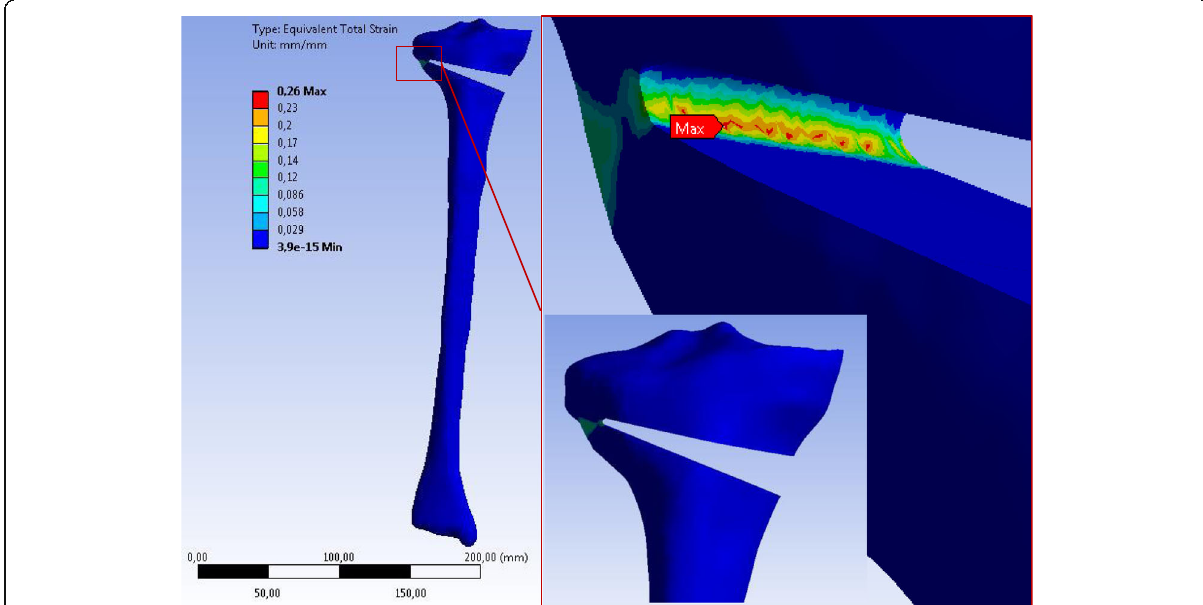
Fig. 16 Equivalent total strain (von-Mises) in the specimen SNH for material case L: The total strain was calculated by nonlinear 3D FEA. The osteotomy gap was opened by 10°. The specimen has been slightly rotated in the enlargement picture